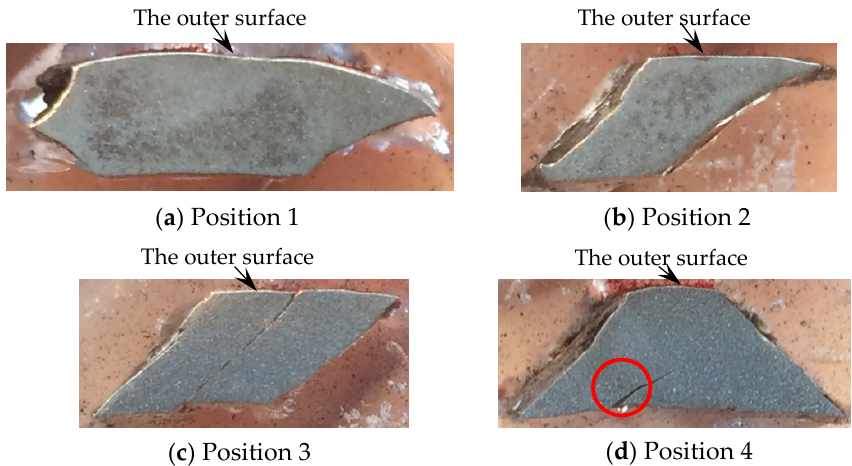
Figure 7. Cross-sections of typical fragments from di ff erent positions of Specimen 1#: ( a ) Cross-section of typical fragment from position 1; ( b ) Cross-section of typical fragment from position 2; ( c ) Cross-section of typical fragment from position 3; ( d ) Cross-section of typical fragment from position 4.